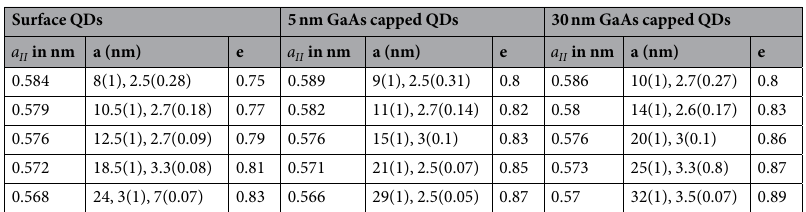
Table 1. Fitting parameters of angular scans: major axes ‘a’ and eccentricity ‘e’ for several a